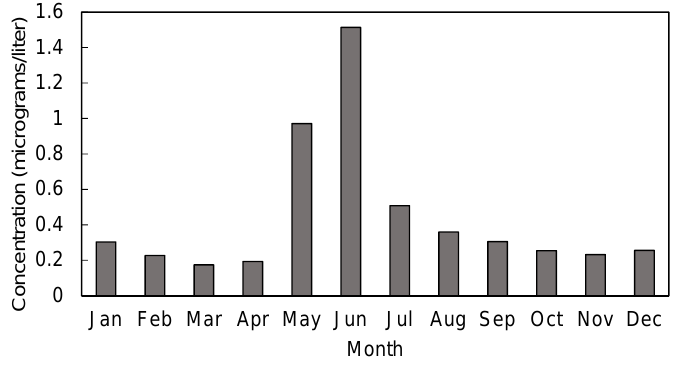
Figure 1. Seasonal variations in mean monthly atrazine concentration ( µ g/L) in finished water samples from 22 AMP community water systems in Ohio, 2006–2008.